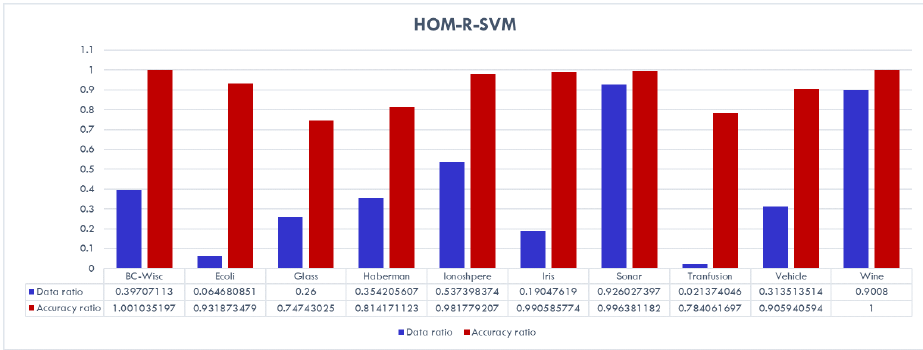
Figure 8. Performance of HOM-R-SVM: data ratio vs. accuracy ratio.